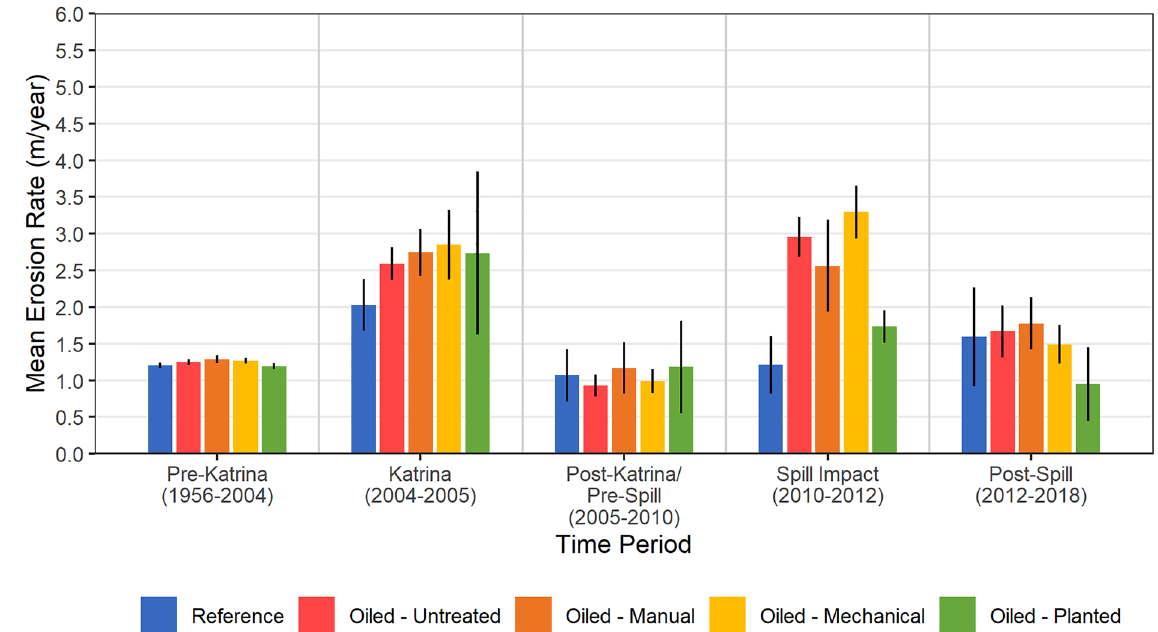
Figure 4. Remote sensing measured marsh shoreline erosion rates 1956–2018 (m yr −1 ). Data are means with 90% confidence intervals, n = 5 for Reference, 9 for Oiled-Untreated, 5 for Oiled-Manual, 9 for Oiled- Mechanical, and 5 for Oiled-Mechanical-Planted treatments. Marsh erosion rates differed among oiling/ treatment categories (F 4,28 = 9.368, p = 0.000); among time-periods (F 2.48,69.47 = 62.210, p = 0.000); and for the interaction of oiling/treatment and time-period (F 9.92,69.47 = 4.593, p = 0.000). In the post-Katrina/pre-spill period (2005–2010) erosion differences were not observed among any oiling/treatment classes, including Reference ( p = 0.868 to 1.000). In the spill impact period (2010–2012) erosion differences were observed between: Reference versus all oiled classes ( p = 0.000 to 0.001) except Planted ( p = 0.410); between the Manual and Mechanical treatments ( p = 0.063); and between Planted versus all other oiled classes ( p = 0.000 to 0.065). In the post-spill period (2012–2018) erosion differences were observed between: Planted versus Untreated and Manual treatments ( p = 0.066 and 0.072). Between the post-Katrina/pre-spill and spill impact time-periods, erosion differences were not observed within the Reference ( p = 0.989) or Planted ( p = 0.340) classes; however, differences were observed between these time-periods within each of the other oiled classes ( p = 0.000 in